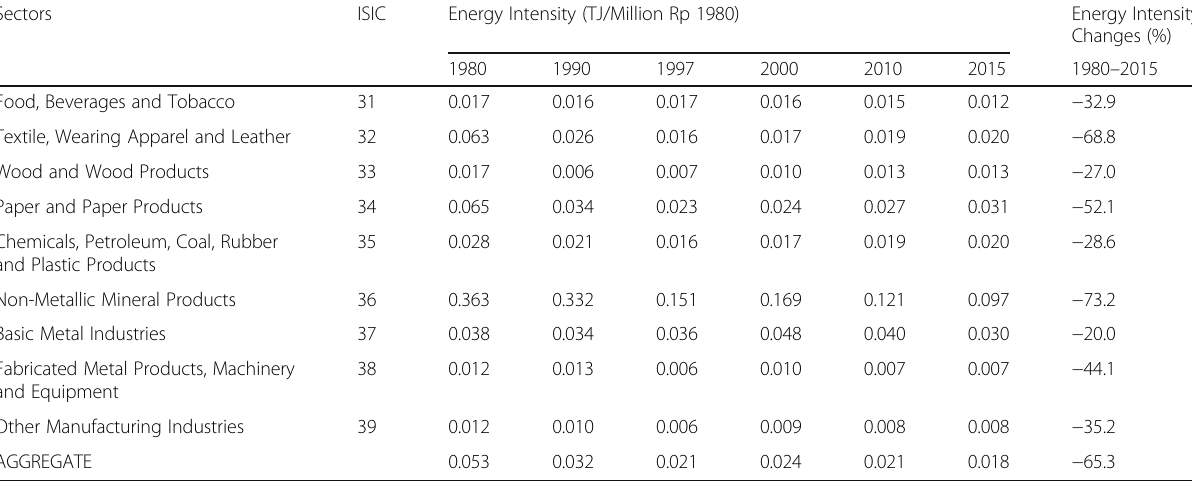
Table 4 Energy intensity of manufacturing sector (ISIC 2 Digit) Sectors ISIC Energy Intensity (TJ/Million Rp